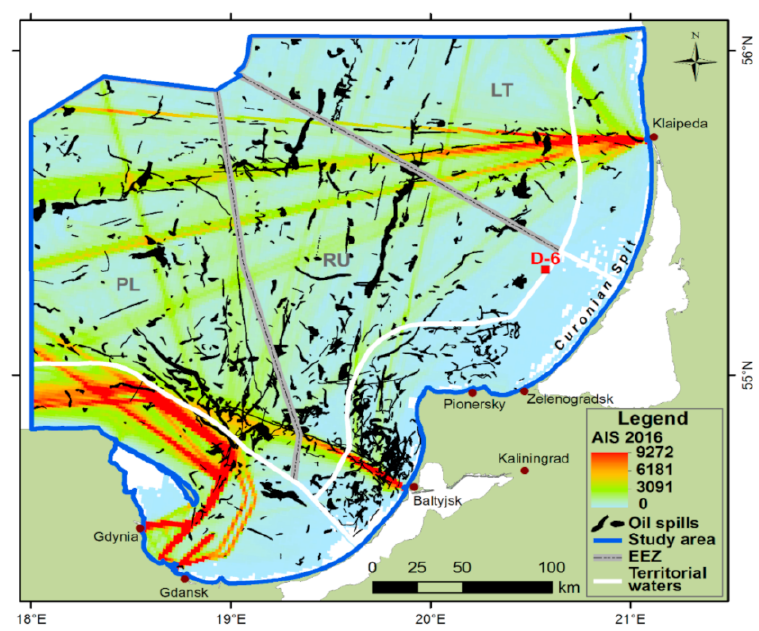
Figure 6. Summary map of oil spills detected from June 2004 to December 2020 within the study area. The color bar shows the monthly average ship traffic according to HELCOM AIS in 2016.